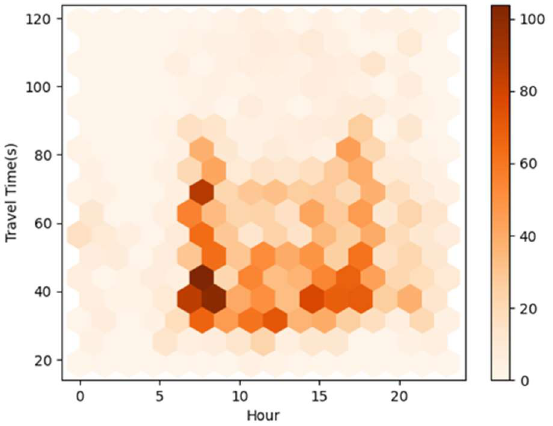
Appl. Sci. 2022 , 12 , x FOR PEER REVIEW Figure 6. Travel time estimation results of hourly density distribution. Figure 6. Travel time estimation results of hourly density distribution.